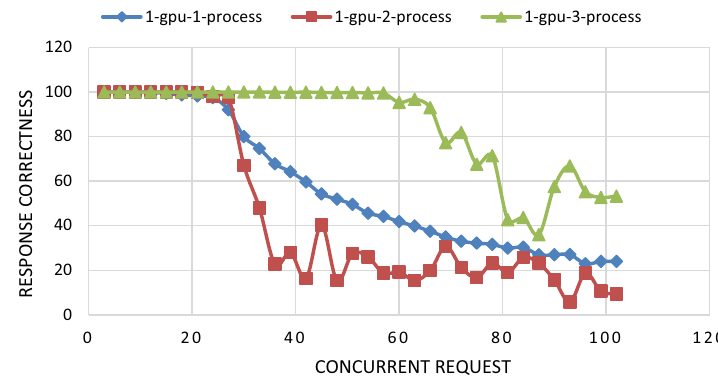
Fig. 4 Success rate % based on the concurrent request for 1 GPU